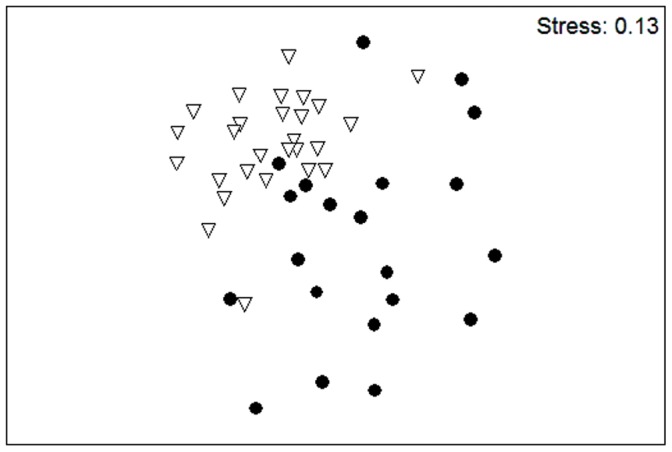
Multi-dimensional scaling plot showing the differences in the fauna assemblage between hollows in remnants (open triangle) hollows in continuous forest (filled circle).